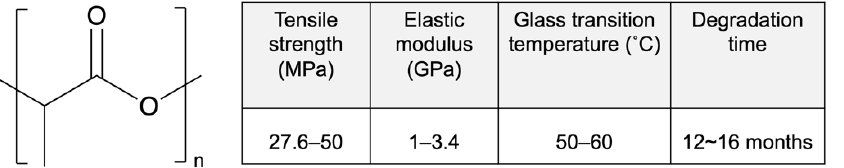
Figure 3. Structure and properties of poly-D,L-lactic acid (PDLLA). Reprinted with permission from [31], published by Elsevier, 2016.